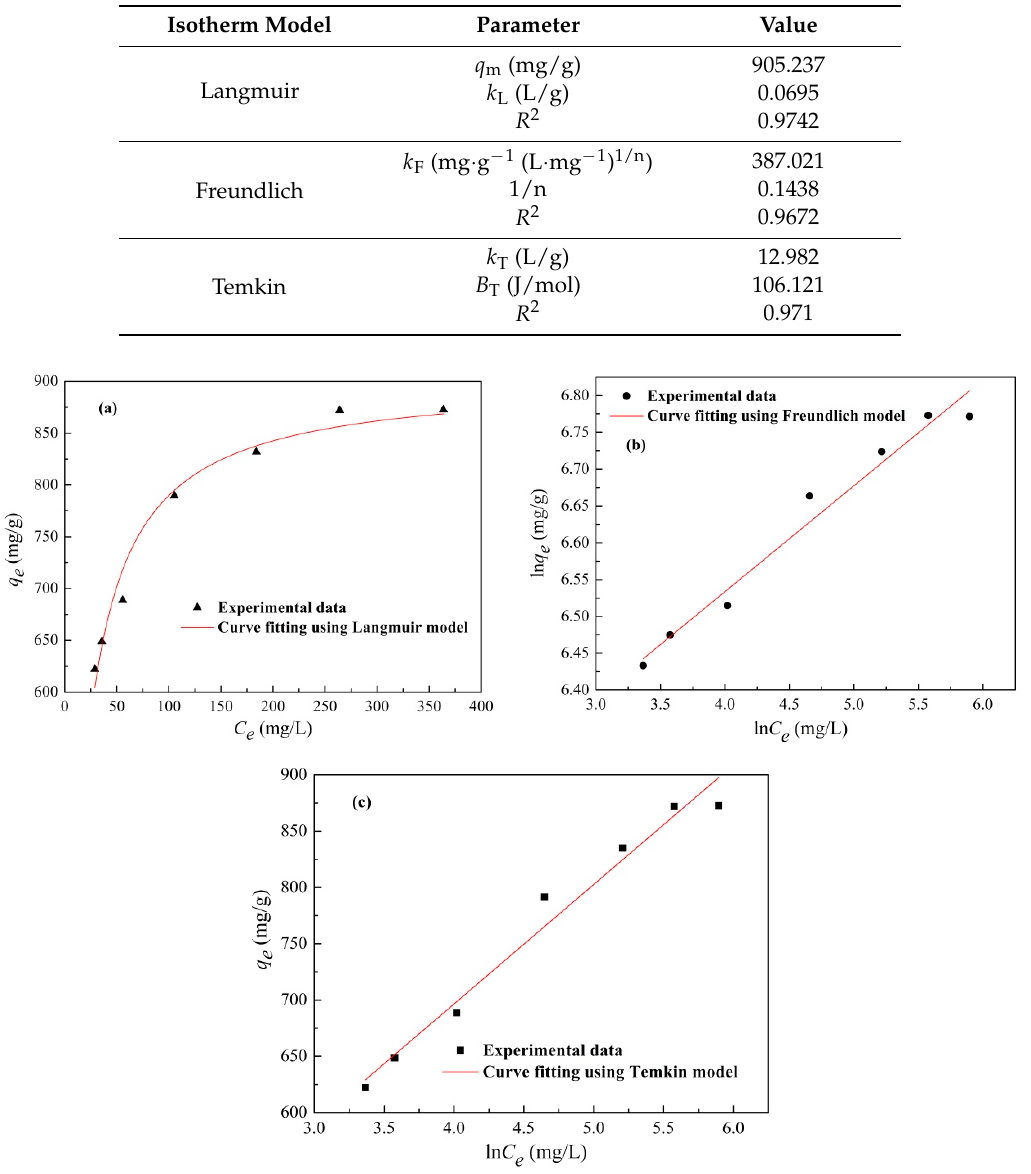
Table 3. Isotherm parameters of Ag + adsorption onto TSC-CC resin at 298 K.